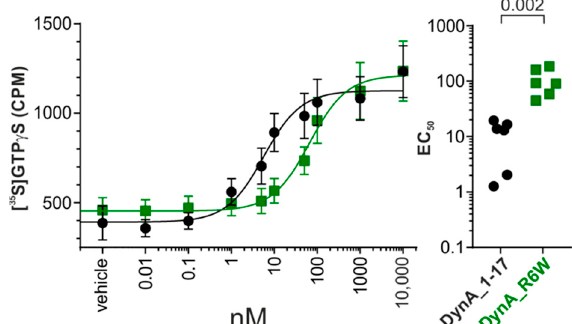
Figure 1. Dynorphin A (DynA)_1-17 and DynA_R6W peptides signal at human kappa opioid receptor (hKOR). Left: Dose response curve of [ 35 S]GTP γ S binding to membranes (10 µ g) from cells expressing hKOR. Right: Summary showing the magnitude of the change in EC 50 induced by DynA_1-17 and DynA_R6W peptides in each experiment. Data are shown as mean ± SEM from six independent experiments. Mann–Whitney test, p -values are indicated in the figure. CPM: counts per minute.